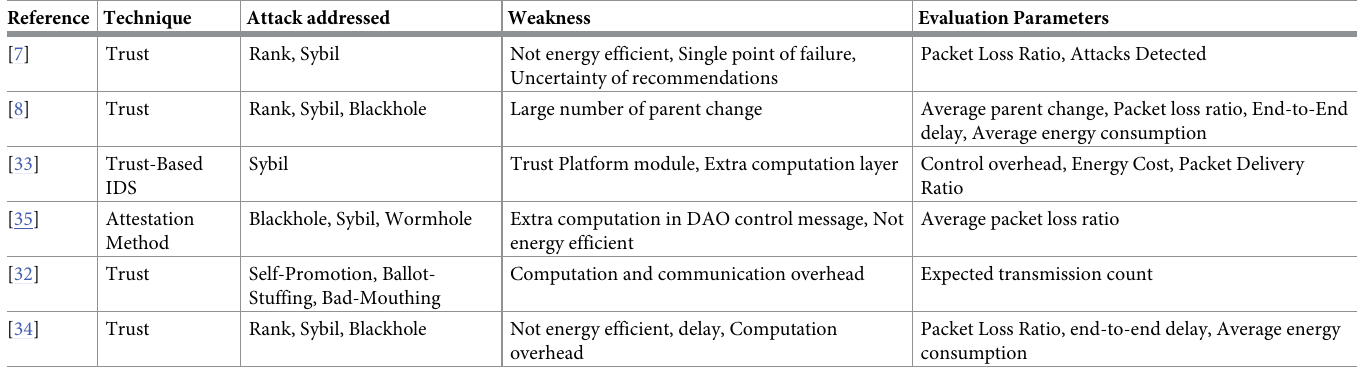
Table 2. State-of-the-art comparison. Reference Technique